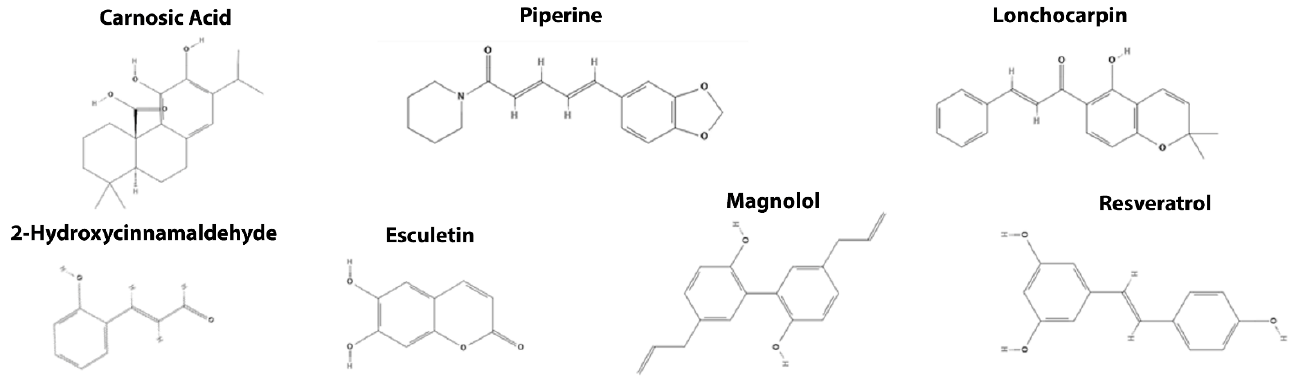
Figure 6. Chemical structures from the naturally occurring small molecules that target the β-catenin transcriptional activity in the Wnt/β-catenin signaling pathway.